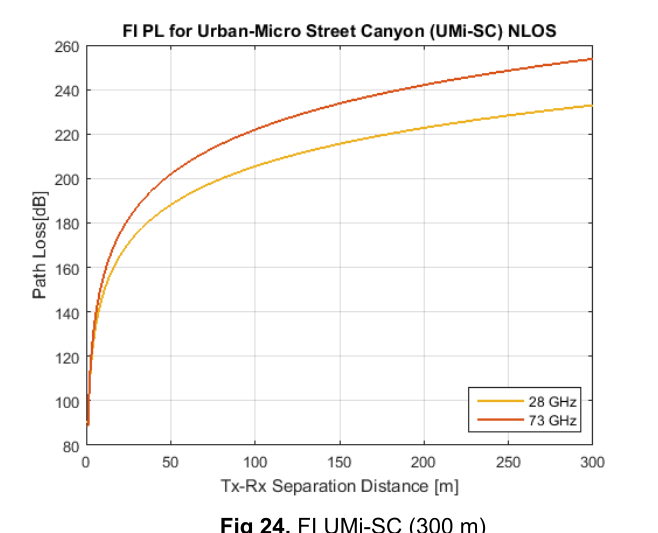
Fig 24. FI UMi-SC (300 m)